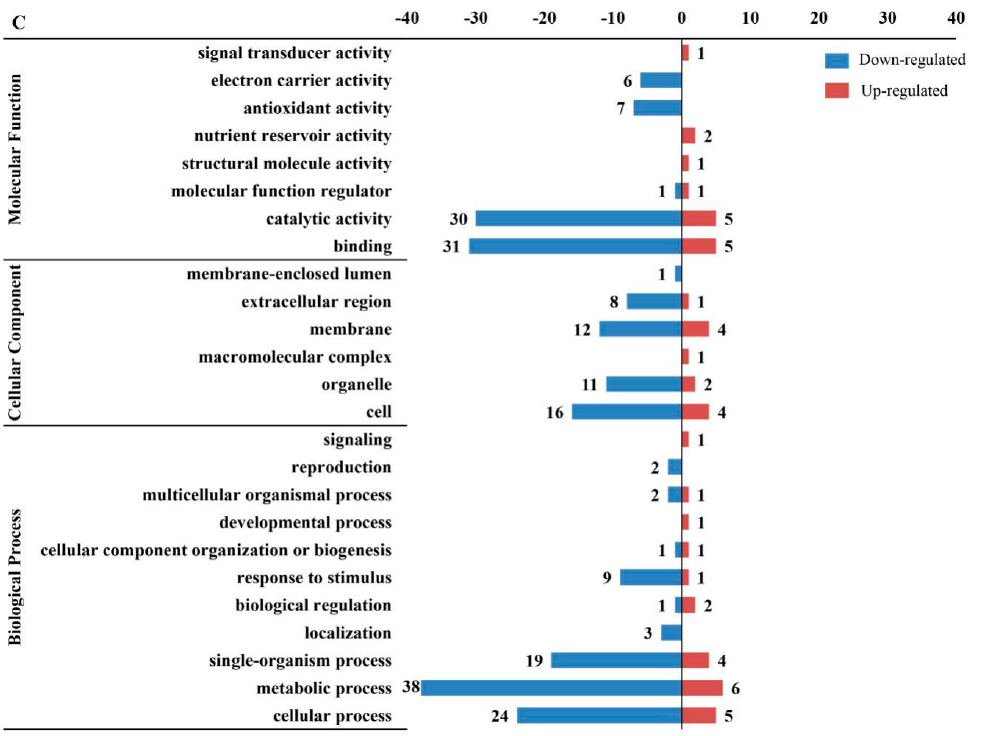
Figure 3. The functional distribution of DEPs in response to AAT by Gene Ontology (GO) level 2. The x -axis represents the number of enriched DEPs by GO annotation)and the note number mean protein number. ( A ) the DEPs of 36 h/0 h by GO; ( B ) the DEPs of 72 h/0 h by GO; ( C ) the DEPs of 72 h/36 h by GO.